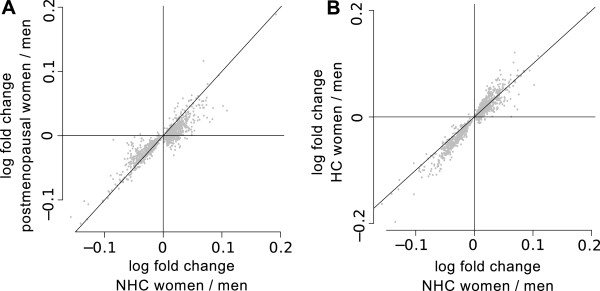
Sex-differences in gene expression are increased by the use of hormonal contraceptives, and decreased during menopause. Women were divided in three groups: postmenopausal, hormonal contraceptive using (HC), and non hormonal contraceptive using (NHC) women. For the 993 sex-biased transcripts identified in the comparison between males and NHC women, fold changes were computed for the difference between the three groups of women and the men. Positive fold changes are from female-biased genes, negative fold changes correspond to male-biased genes. A)  Fold changes are for 80% larger in NHC women as compared to postmenopausal women. B) Fold changes in HC women are for 66% larger than those observed in NHC women, and the negative fold changes (male-biased genes) were for 88% larger in HC women.